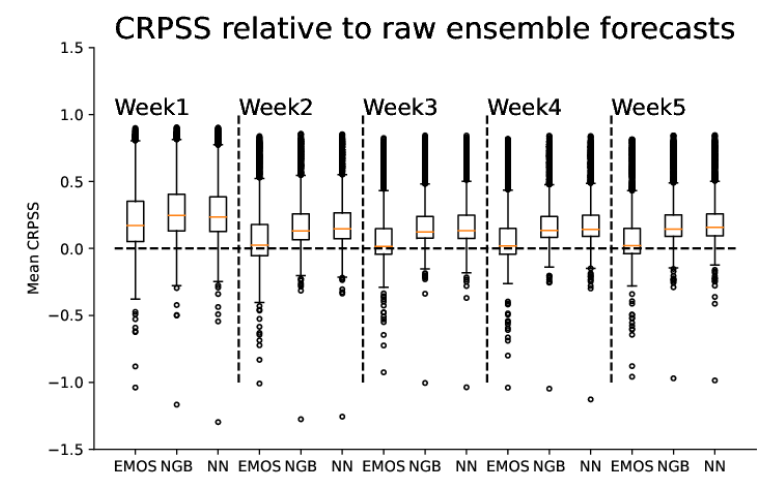
Figure 4. Boxplots of the mean continuous ranked probability skill score of all the post-processing models at different lead times using the raw ensemble as the reference forecast. CRPSS, continuous ranked probability skill score; EMOS, ensemble model output statistics; NGB, natural gradient boosting; NN, neural network.